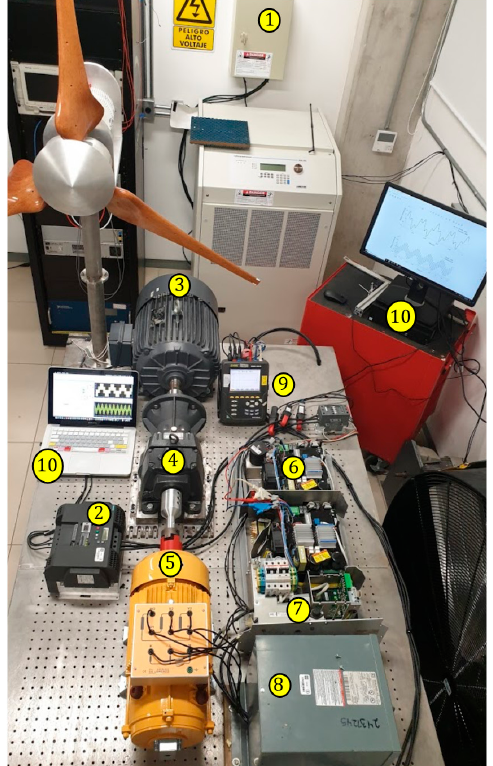
Figure 8. Experimental setup of the tested DFIG.